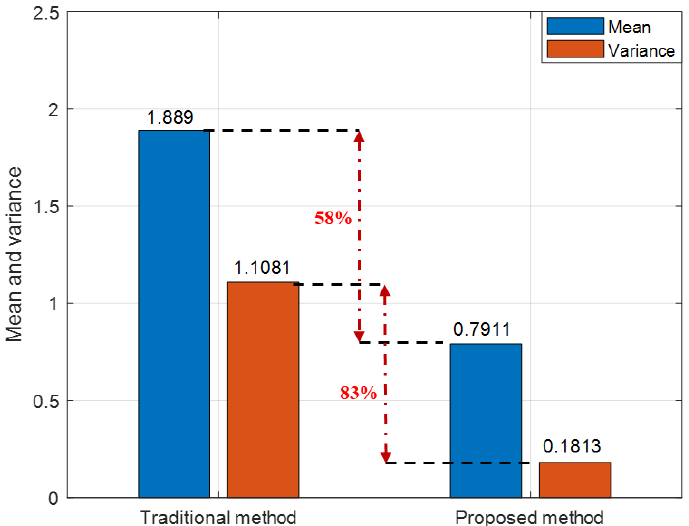
Figure 9. Mean and variance of follower UAV’s positioning error using traditional method and proposed method.